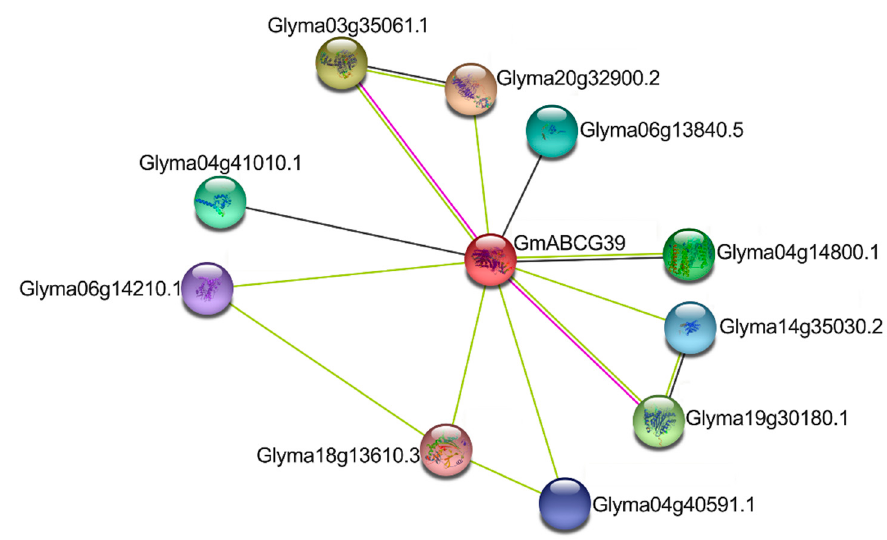
Figure 4. Predicted interacting proteins of GmABCG39. The fuchsia solid lines indicate experimentally determined proteins, the light green solid lines indicate gene neighbourhoods, the black solid lines indicate coexpression, the coloured nodes indicate query proteins and the first shell of interactors, the empty nodes indicate proteins of unknown 3D structure, and the filled nodes indicate that some 3D structure is known or predicted.